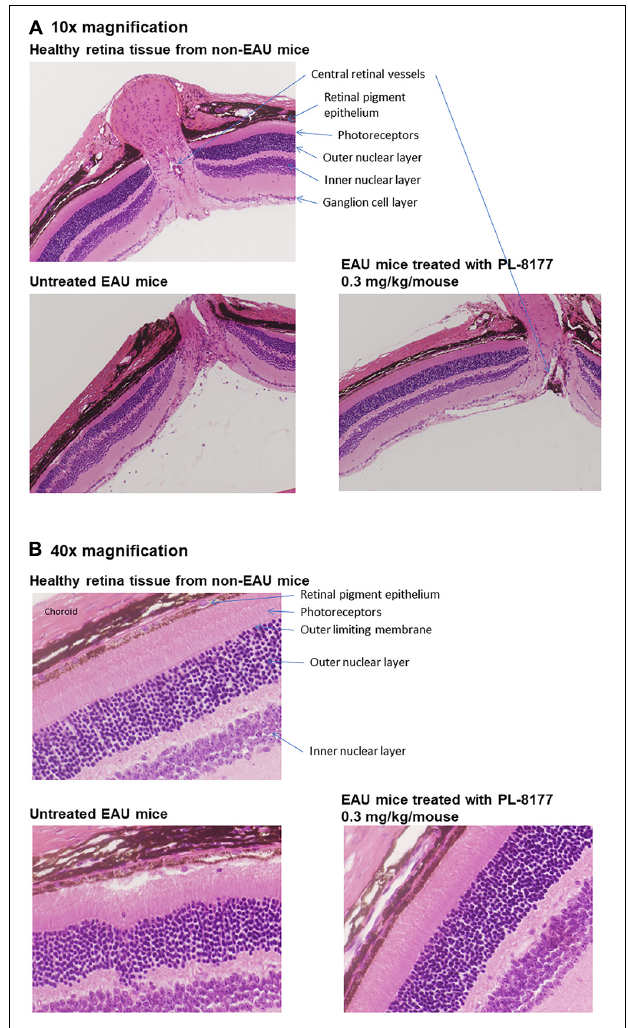
FIGURE 4 | (A) Histology of retinas from healthy mice (Top), untreated EAU mice (Lower Left), and EAU mice treated with PL-8177 0.3 mg/kg/mouse (Lower Right). In contrast with the healthy retinas, the retinas from the untreated mice showed: cellular infiltration; uneven nuclear layers with folding; loss of the outer limiting membrane; loss of the intervening plexiform layer between the inner and outer nuclear layers in some places; a thinner photoreceptor layer, suggesting photoreceptor dropout; and signs of vasculitis in the central retinal vessels. (B) At higher magnification (40 × ), disruption of the retinal pigment epithelial monolayer and presence of immune cells in the photoreceptor layer were detectable. In contrast to the untreated retinas (Lower Left), EAU retinas treated with PL-8177 (Lower Right) retained the even layers of the retina with little evidence of photoreceptor loss [similar thickness of photoreceptor layer as in healthy eyes (Top)], and some of the outer limiting membrane. The retinal pigment epithelial monolayer was intact and there was a clear outer plexiform layer between the inner and outer nuclear layers. One detectable difference between the healthy retinas (Top) and the PL-8177-treated EAU retinas (Lower Right ) is that photoreceptor nuclei were not lined up in the latter as they were in the healthy